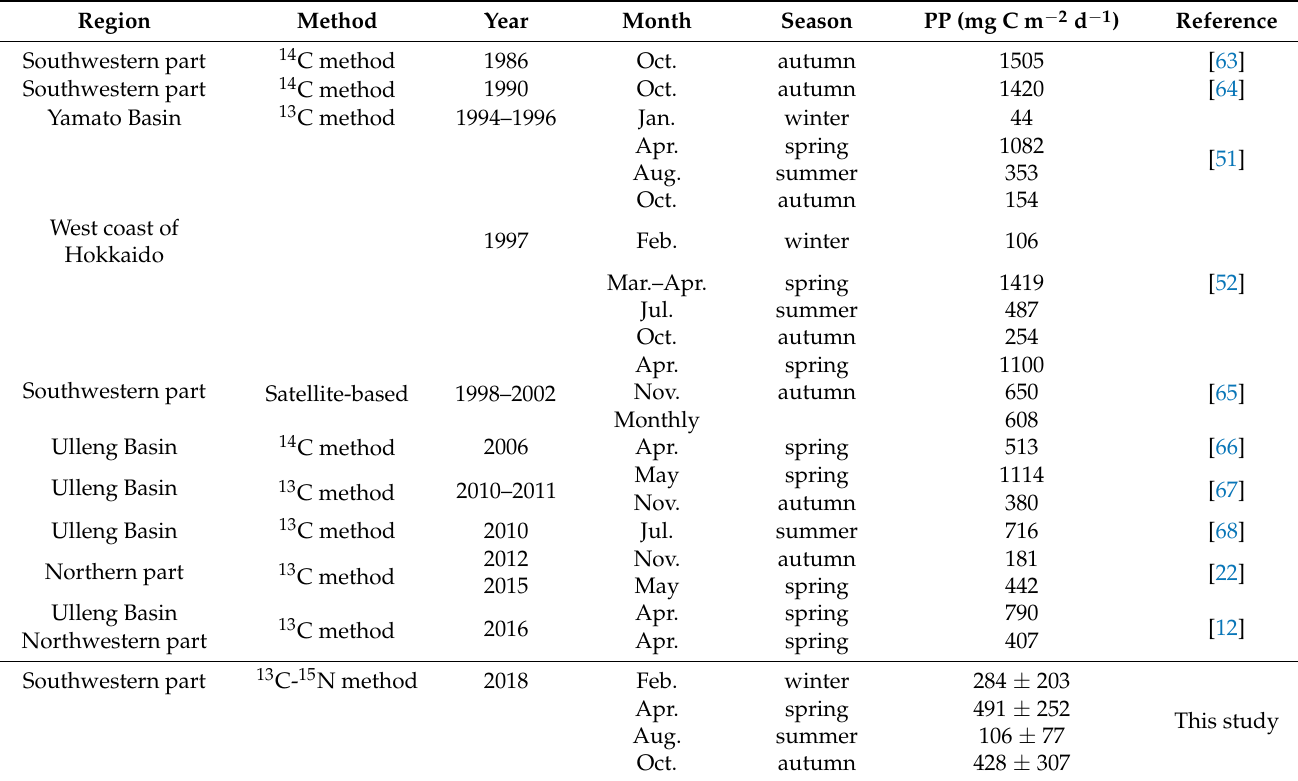
Table 5. Comparisons of daily primary production in the EJS. PP represents daily primary production.